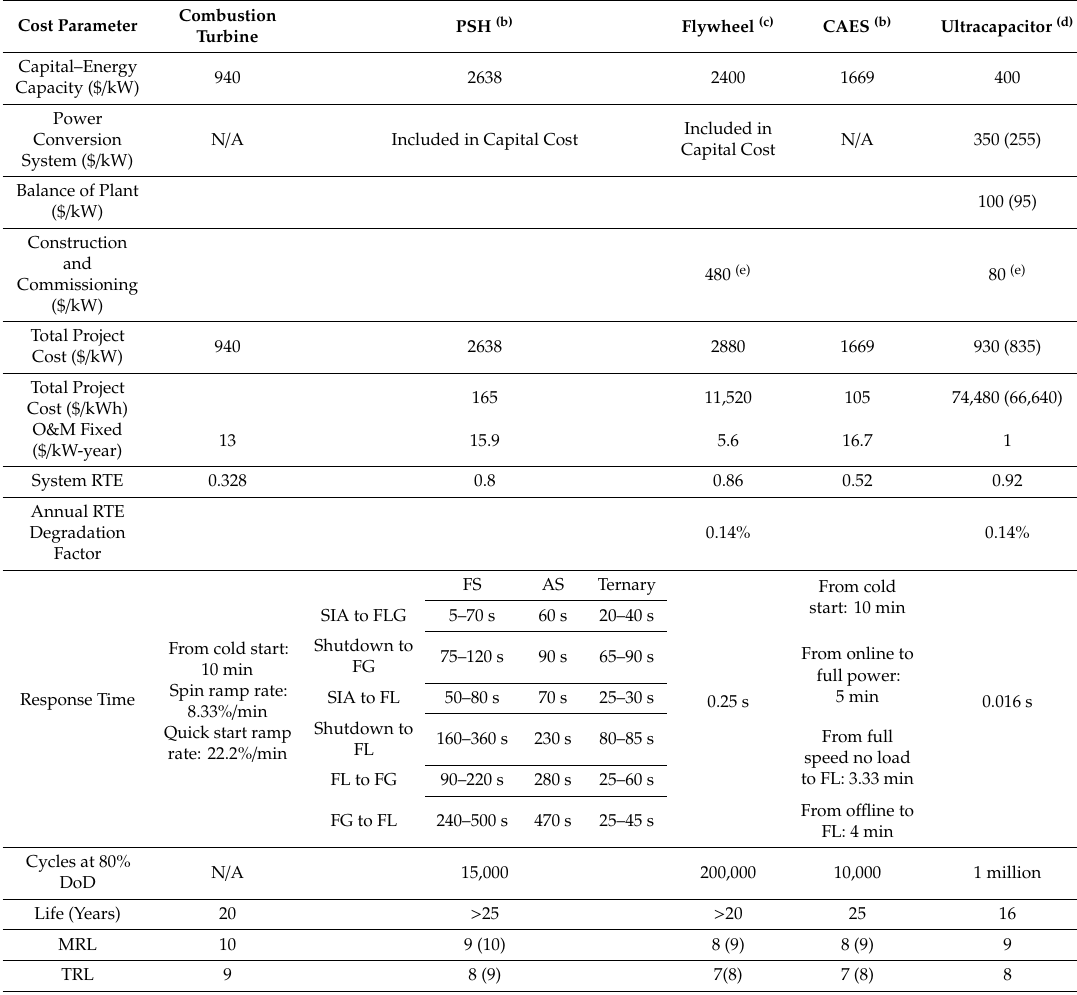
Table 8. Summary of compiled 2018 findings and 2025 predictions for cost and parameter ranges by